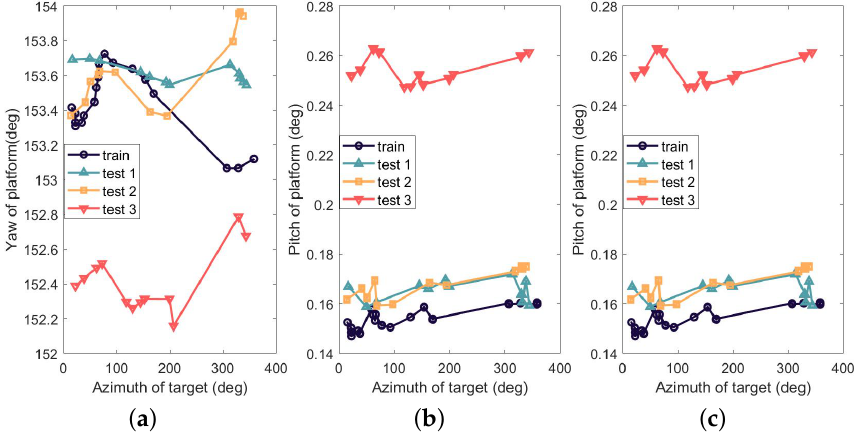
Figure 10. Attitude of moving-platform ( a ) in Yaw ( b ) in Pitch ( c ) in